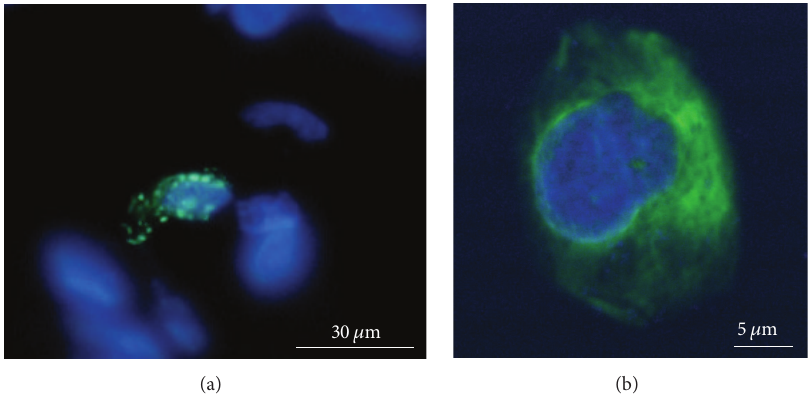
Figure 4: Confocal fluorescence microscopy of a representative osteoclast-like cell positive for TRAP (a) and an immature dendritic cell positive for intracellular MHC class II (b).